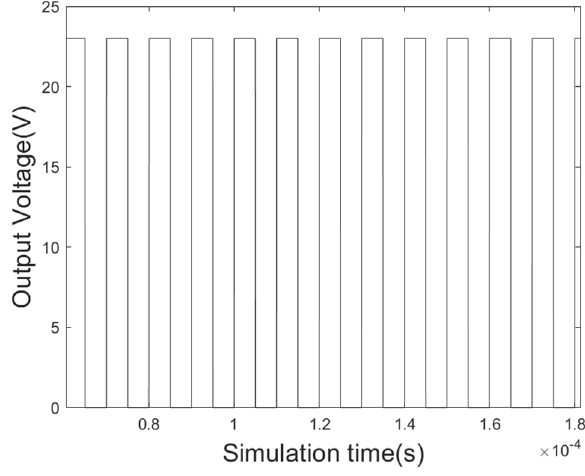
Figure 15. Voltage waveform of inverter output.